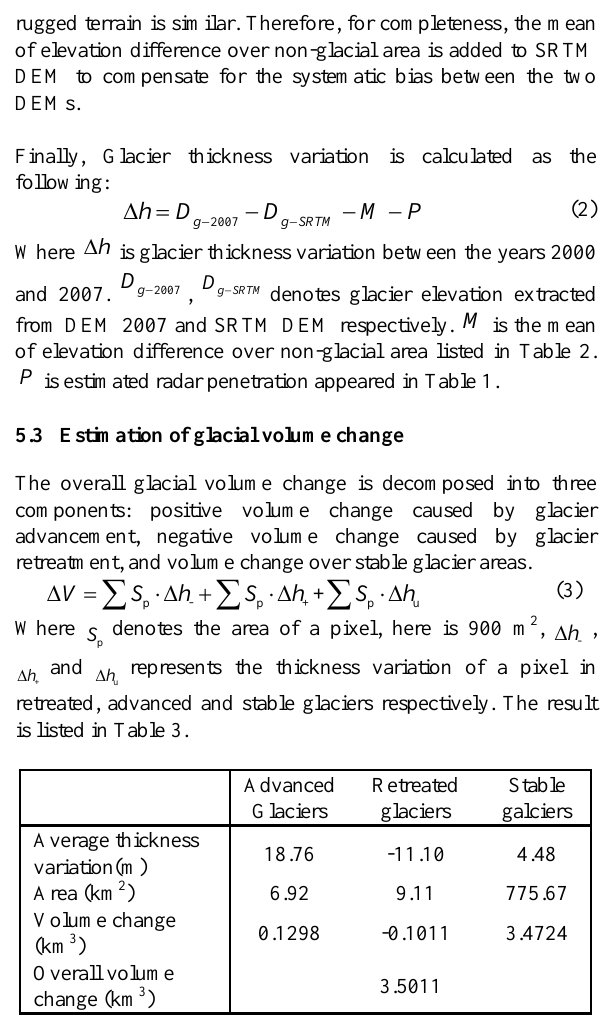
Table 3. Glacier volume change between the year 2000 and